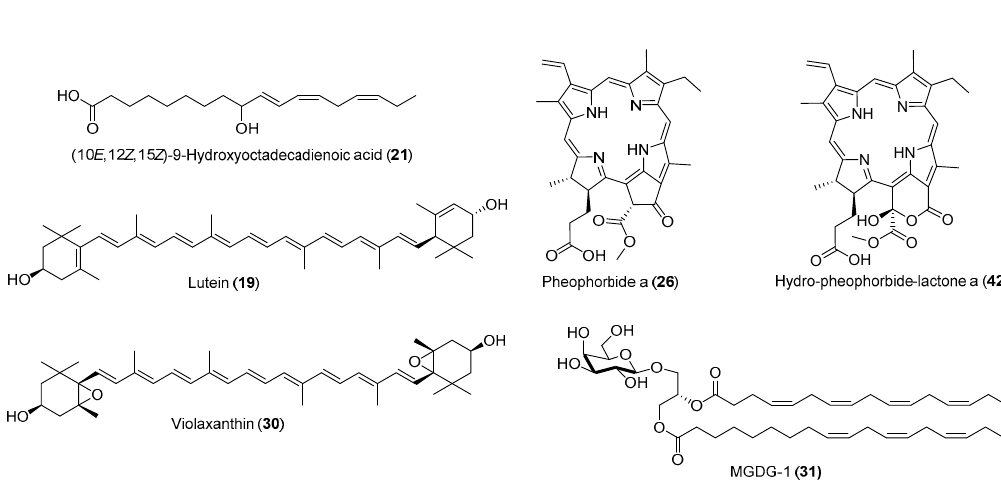
Figure 3. Structures of anti-inflammatory compounds from K. flaccidum var. zivo .